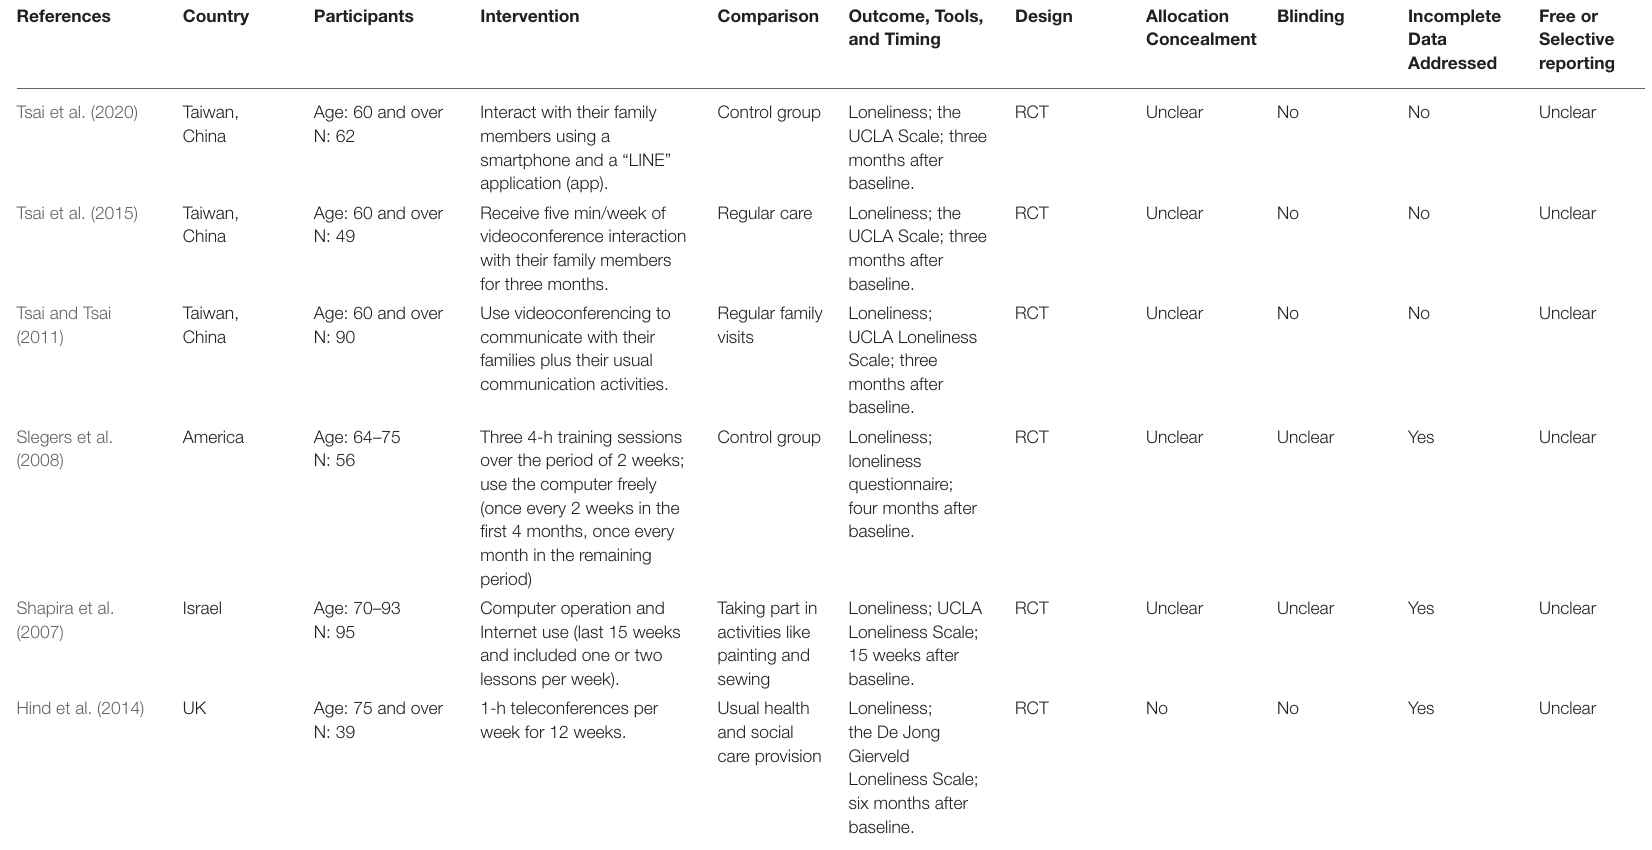
TABLE 1 | Participant characteristics and study methods of included